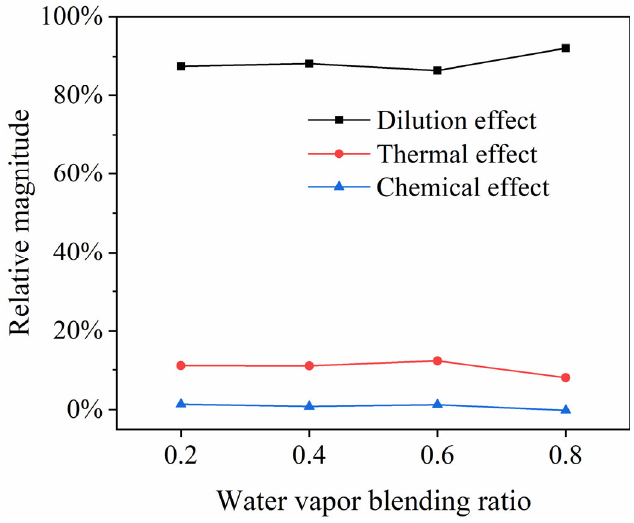
Figure 16. The relative magnitude of effects of water vapor.